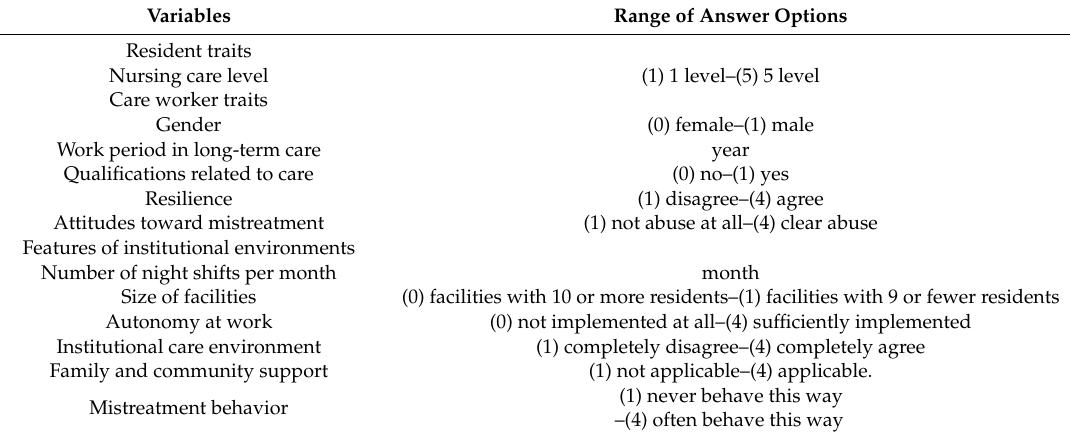
Table 1. Detailed information about the variables and